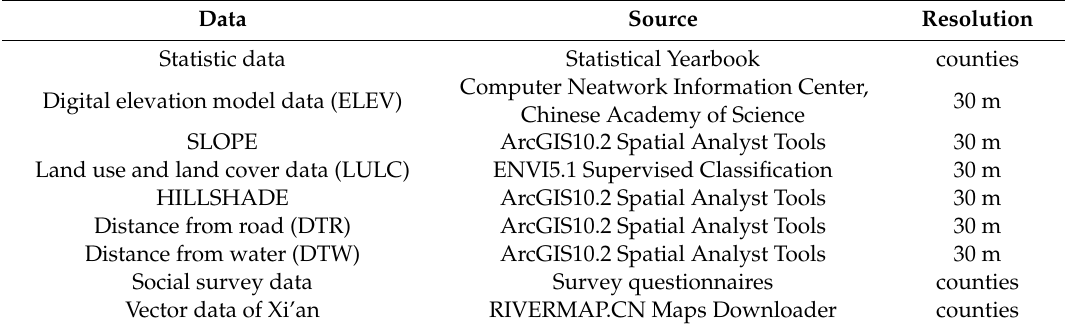
Table 3. Data sources.